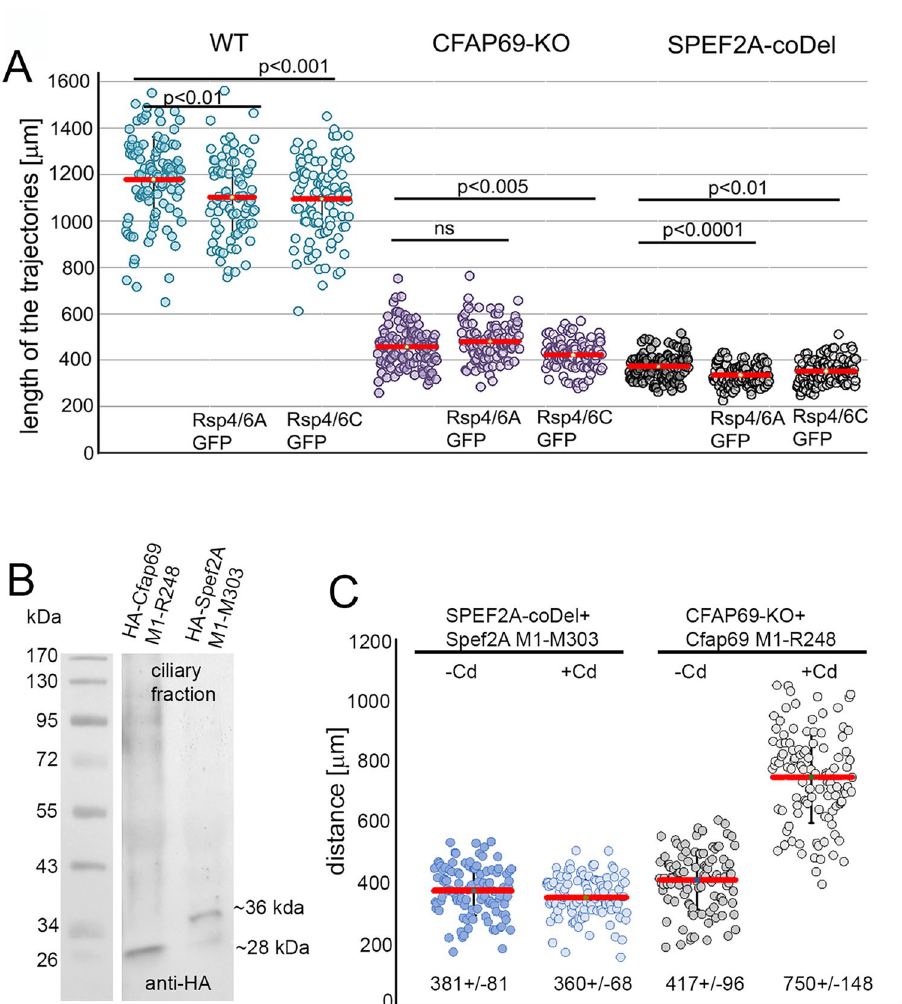
Figure 5. Overexpression of the truncated variant of Cfap69 but not expression of the GFP-tagged radial spoke head proteins partly restores CFAP69-KO mutant cells motility. ( A ) Graph showing the comparison of the distances swum by wild-type (WT) and analyzed mutants during 3.2 s, expressing either Rsp4/6A-GFP or Rsp4/6C-GFP under the control of the respective native promoters. Error bars represent standard deviation (SD). Travelled distances (in µm) with SD and number of analyzed trajectories (N): WT: 1178 ± 185, N = 100; WT + Rsp4/6A-GFP: 1102 ± 170, N = 81, WT_Rsp4/6C-GFP: 1094 ± 166, N = 100, CFAP69-KO: 458 ± 91, N = 106, CFAP69-KO + Rsp4/6A: 479 ± 85, N = 104, CFAP69-KO + Rsp4/6C: 422 ± 64, N = 102, SPEF2A-coDel: 372 ± 56, N = 106, SPEF2A-coDel + Rsp4/6A:335 ± 45, N = 100, SPEF2A-coDel + Rsp4/6C: 352 ± 53, N = 106. p values calculated using t-test. ( B ) The western blot analysis of the level of expression of HA-Cfap69 M1-R248 and HA-Spef2A M1-M303 truncations in cilia of CFAP69-KO and SPEF2A-coDel cells respectively. ( C ) Graph showing the comparison of the distances swum during 3.2 s by SPEF2A-coDel cells with introduced transgene enabling expression of the HA-Spef2A M1-M303 truncation and CFAP69-KO cells with introduced transgene enabling expression of the HA-Cfap69 M1-R248 truncation, either non-induced (−Cd) or induced (+ Cd) to overexpressed truncated protein. Error bars represent standard deviation. Numbers below the graph indicate the distance swum by the analyzed cells. Number of measurements: N = 103, N = 107, N = 102, N = 107, respectively. Difference observed in FAP69-KO + Cfap69 M1-R248 −/ + Cd is statistically significant ( p < 0.01,